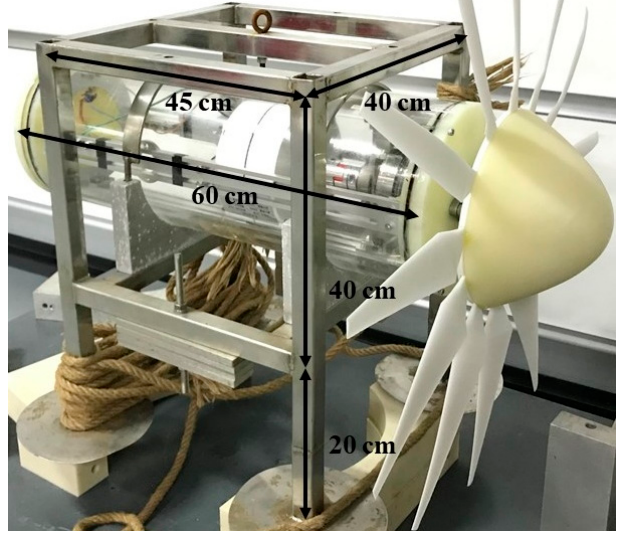
Figure 18. The assembled LOCH.